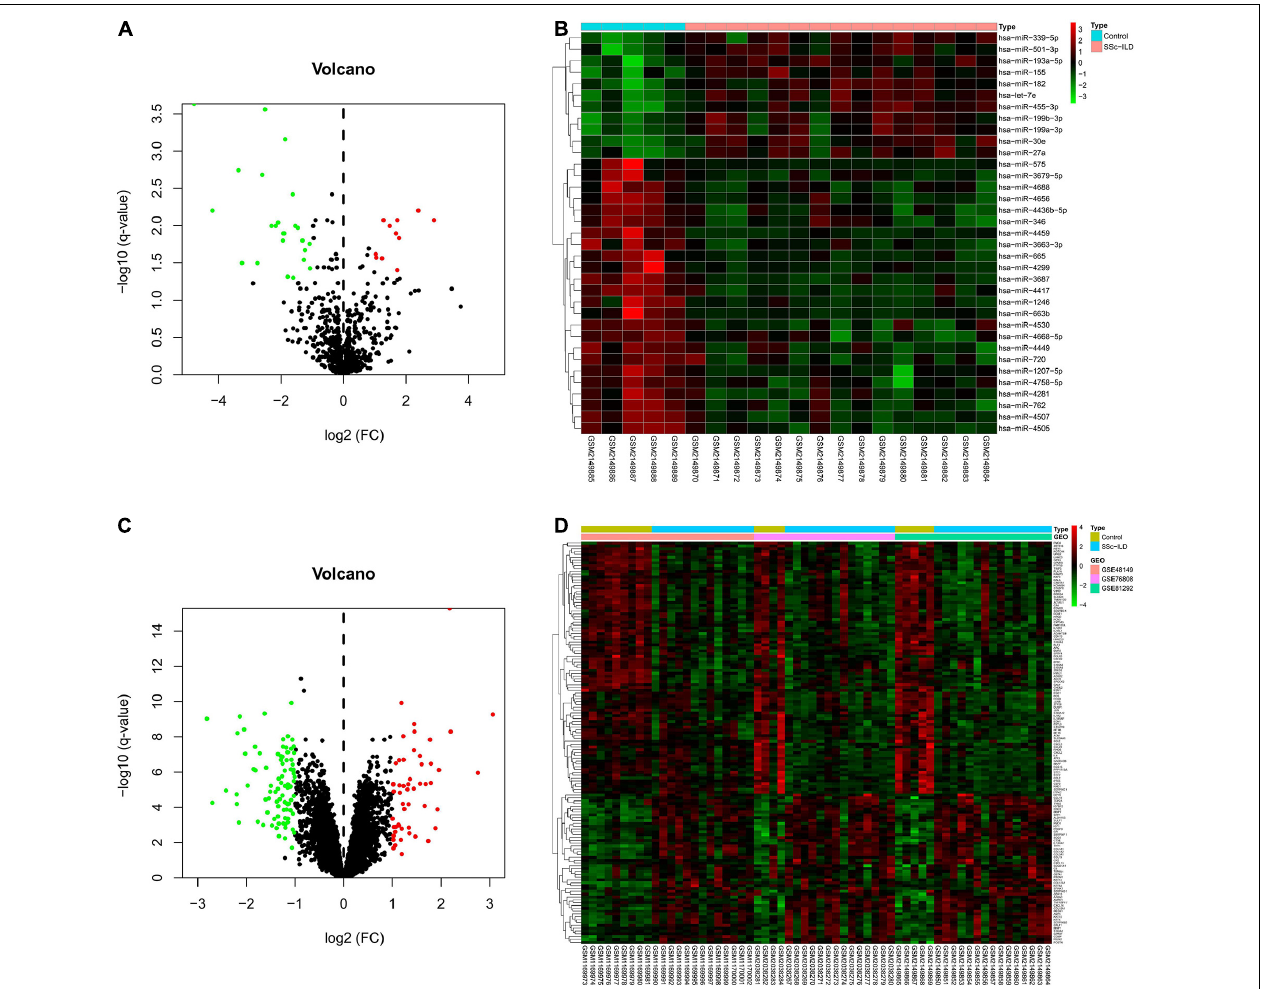
FIGURE 1 | DEmiRs and DEMs in lung tissues between SSc-ILD patients and normal controls. (A) The volcano plot of DEmiRs. (B) The heat map of DEmiRs. (C) The volcano plot of DEMs. (D) The heat map of DEMs. DEmiRs, differentially expressed microRNAs; DEMs, differentially expressed messenger RNAs; SSc-ILD, systemic sclerosis-associated interstitial lung